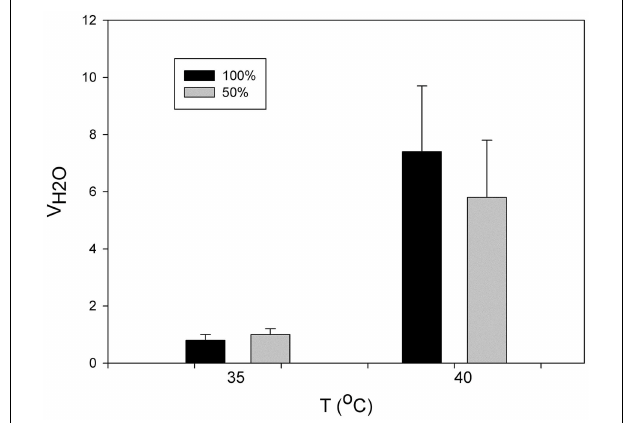
FIGURE 3 | Variation in the mass specific evaporative water loss (V H2O ) as function of temperature in the mygalomorphae spider Paraphysa parvula with 50% (gray bars) and 100% (black) of spiracles open (modified from Figueroa et al., 2010).